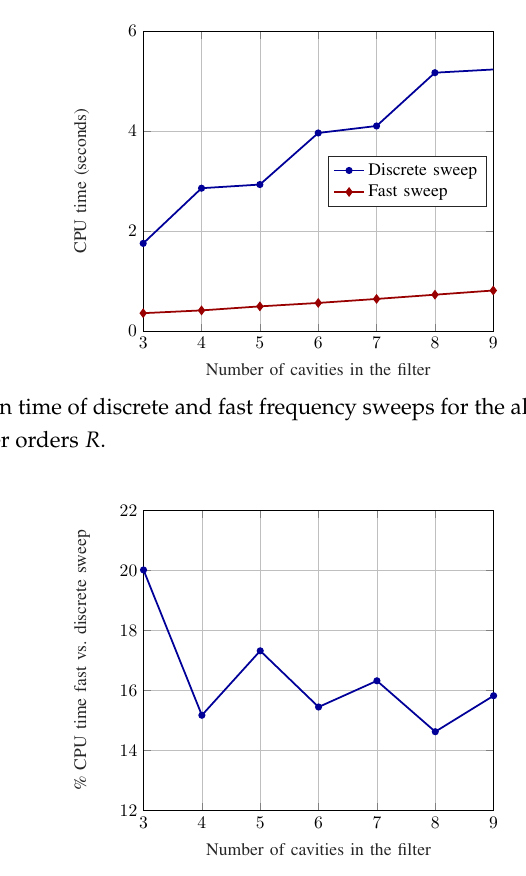
Figure 6. Percentage of computation time of the fast frequency sweep when compared with the discrete sweep for different filter orders R .